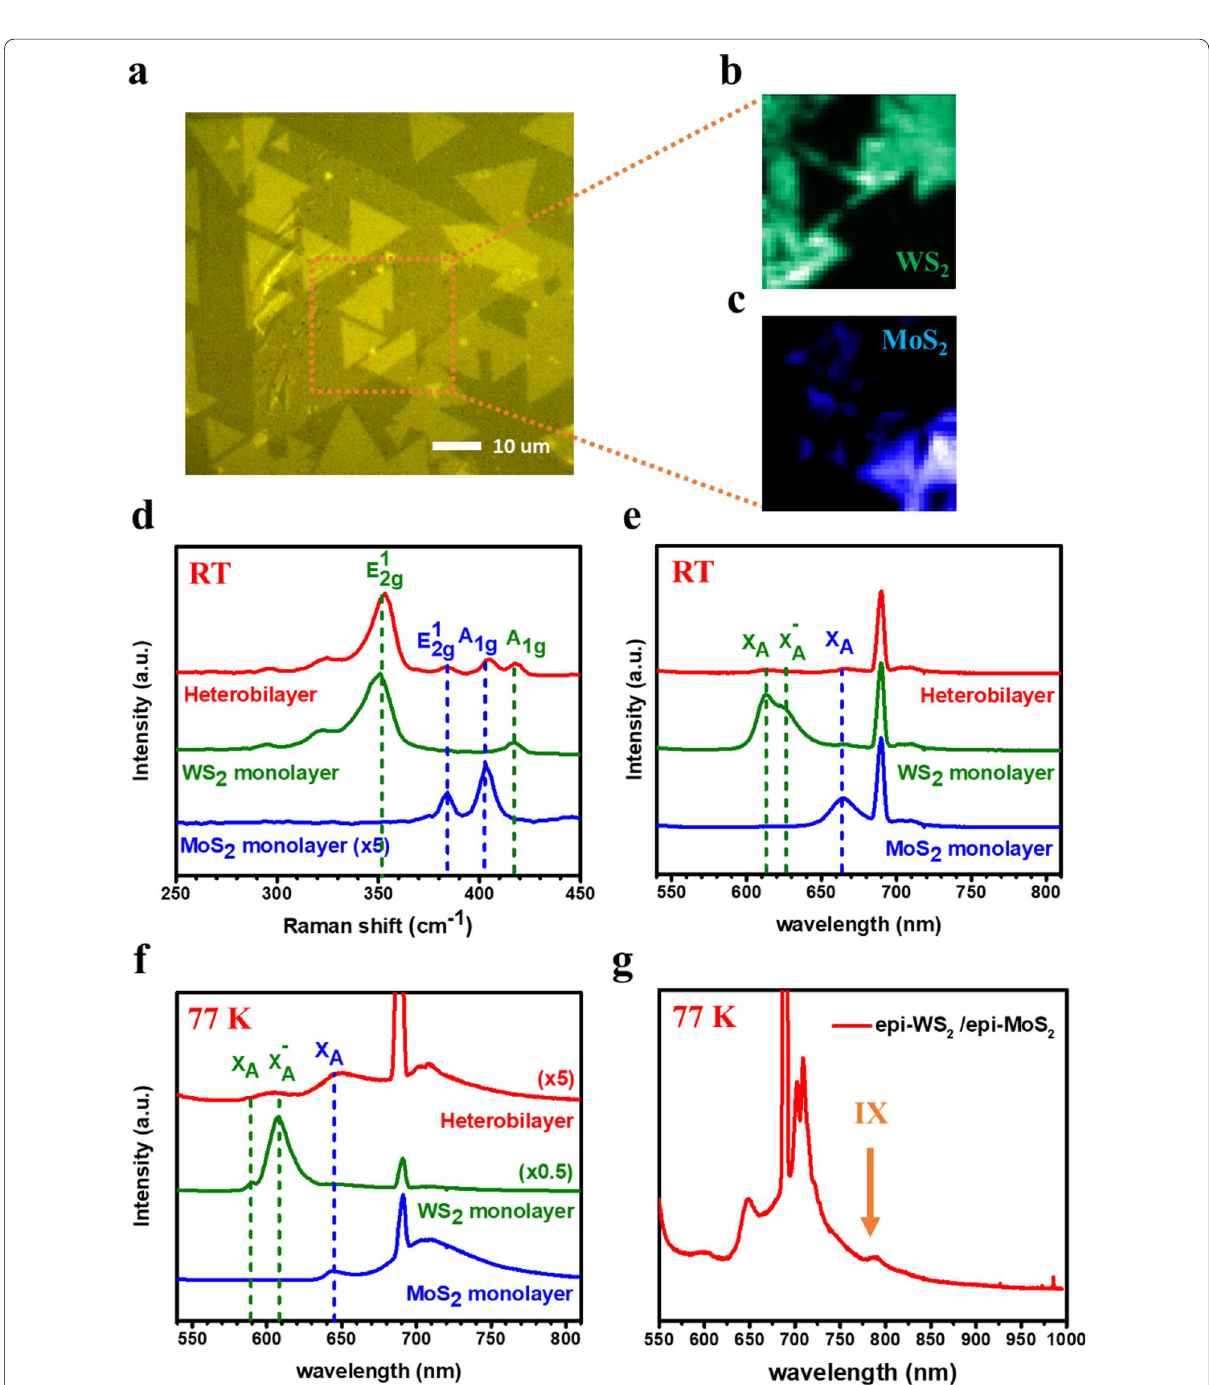
Fig. 3 Strong interlayer coupling at the stacked bilayer of the oriented monolayers. a OM image of the stacked bilayer of the epi‑WS 2 and the epi‑MoS 2 . PL mapping of b epitaxial monolayer WS 2 and c epitaxial monolayer MoS 2 . d Raman and e PL spectra at room temperature. f PL spectra and g interlayer exciton emission at low temperature of 77